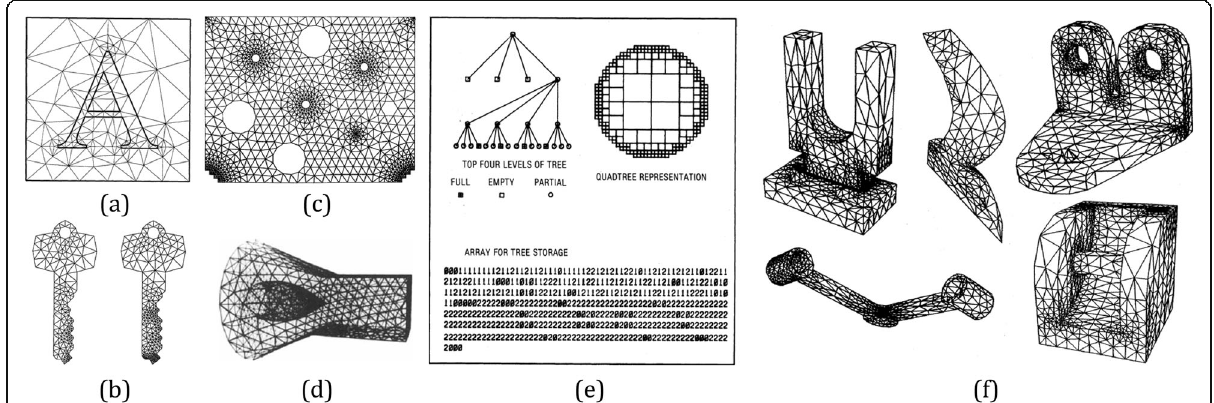
Fig. 3 a Triangulation produced by the Delaunay refinement algorithm with minimum angle ≈ 20 ° [35]. b Based on a minimum angle ≈ 33 ° , the left mesh is formed by always splitting the worst existing triangle, and the right mesh is formed by using a first-come first-split queue of bad triangles [36]. c Based on a domain with many holes, refined meshes can be progressively generated around points of interest [37]. d 3D unstructured grids generated by the advancing-front method [38]. e The finite element mesh of a circle generated via quadtree representation, [39]. f Automatic 3D mesh generation by the modified-octree technique